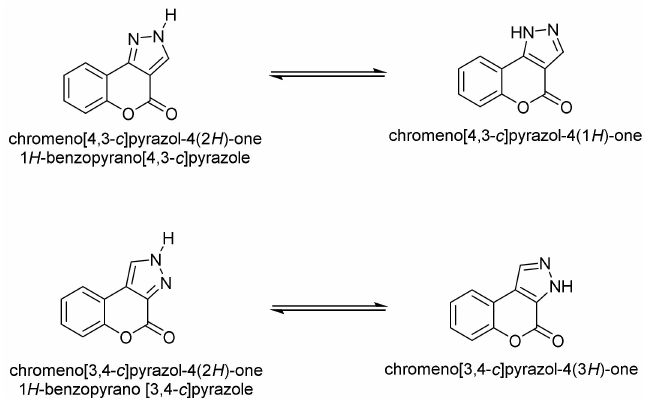
Figure 1. The isomers of fused chromeno-pyrazole.